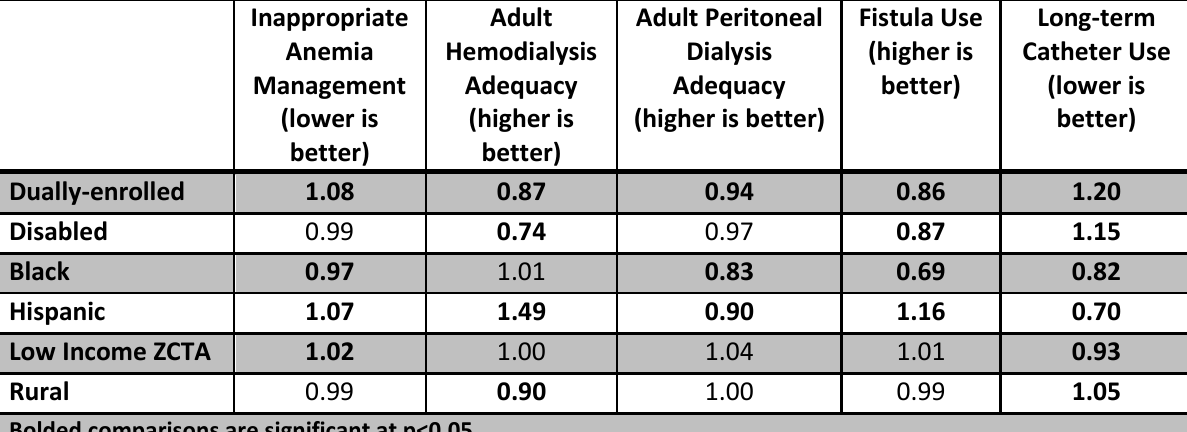
Fistula Use Long-term (higher is Catheter Use better) (lower is better)